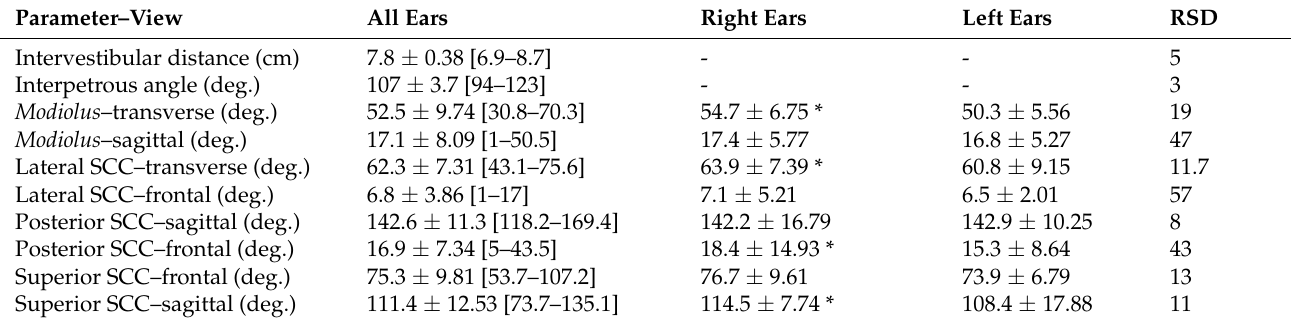
Table 1. Radiological measurements of inner ear structures on high-resolution CT scans: modiolar axis, semicircular canals, intervestibular distance, and interpetrous angle measurements on three orthogonal conventional multiplanar plan reconstructions. Values are expressed as means ± standard deviation [min-max]. Distances are expressed in centimeters and angles in degrees. SCC: semicircular canals. RSD: relative standard deviation, expressed as a percentage, *: p < 0.05 (paired t -test, right versus left ears, n =